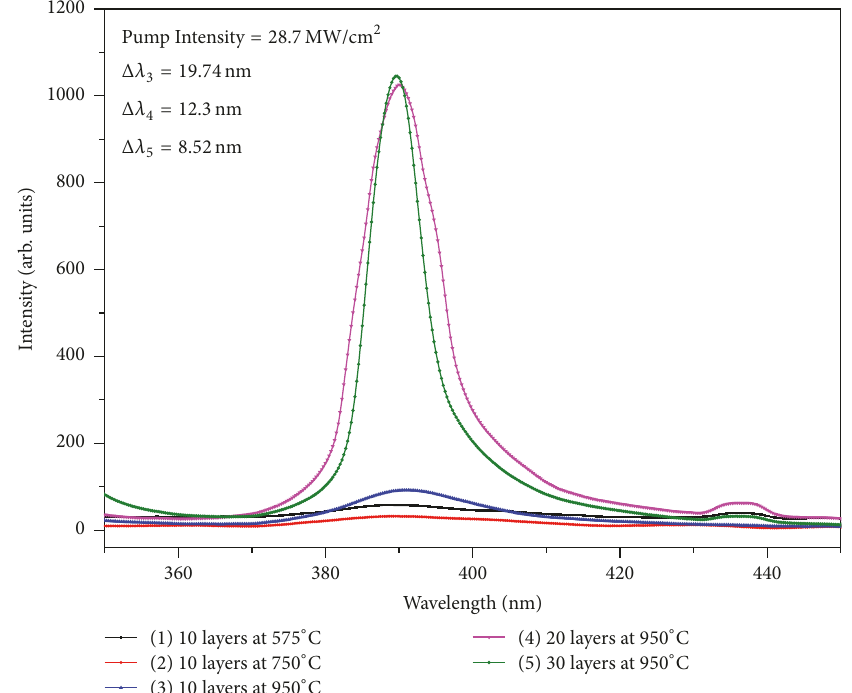
Figure 3: Progress of emission at different preparation conditions at pump intensity [28.7 MW/cm 2 ].